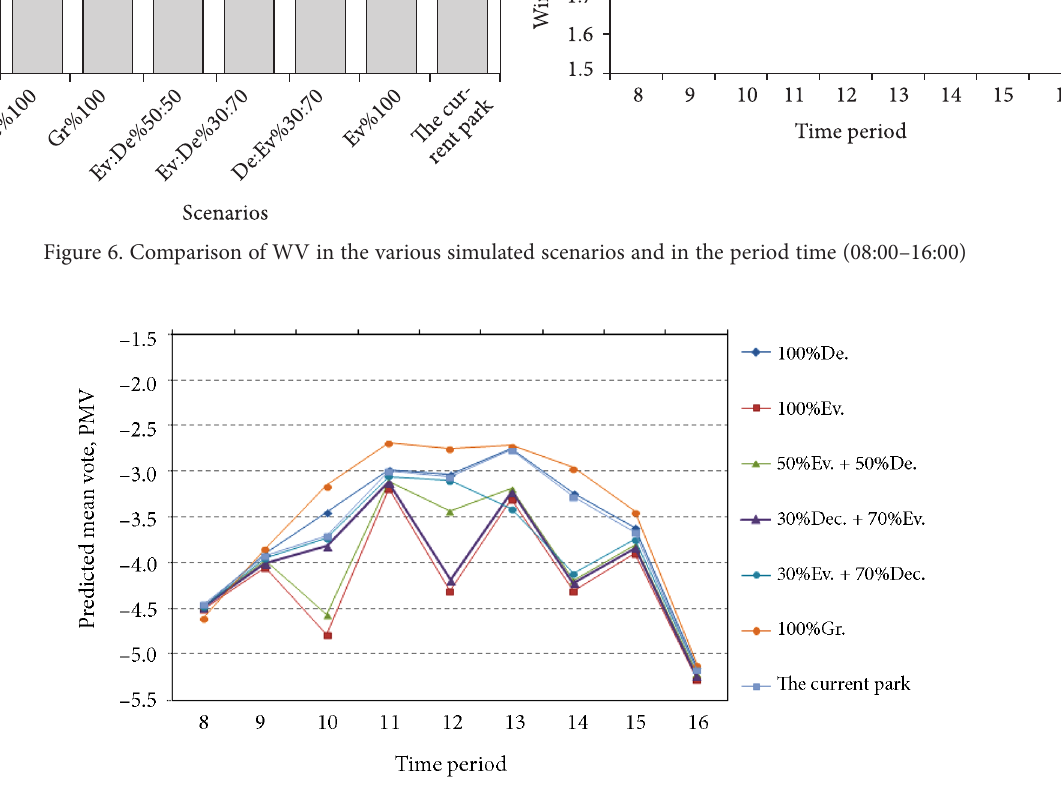
Figure 7. Comparison of PMV in the various simulated scenarios during the period